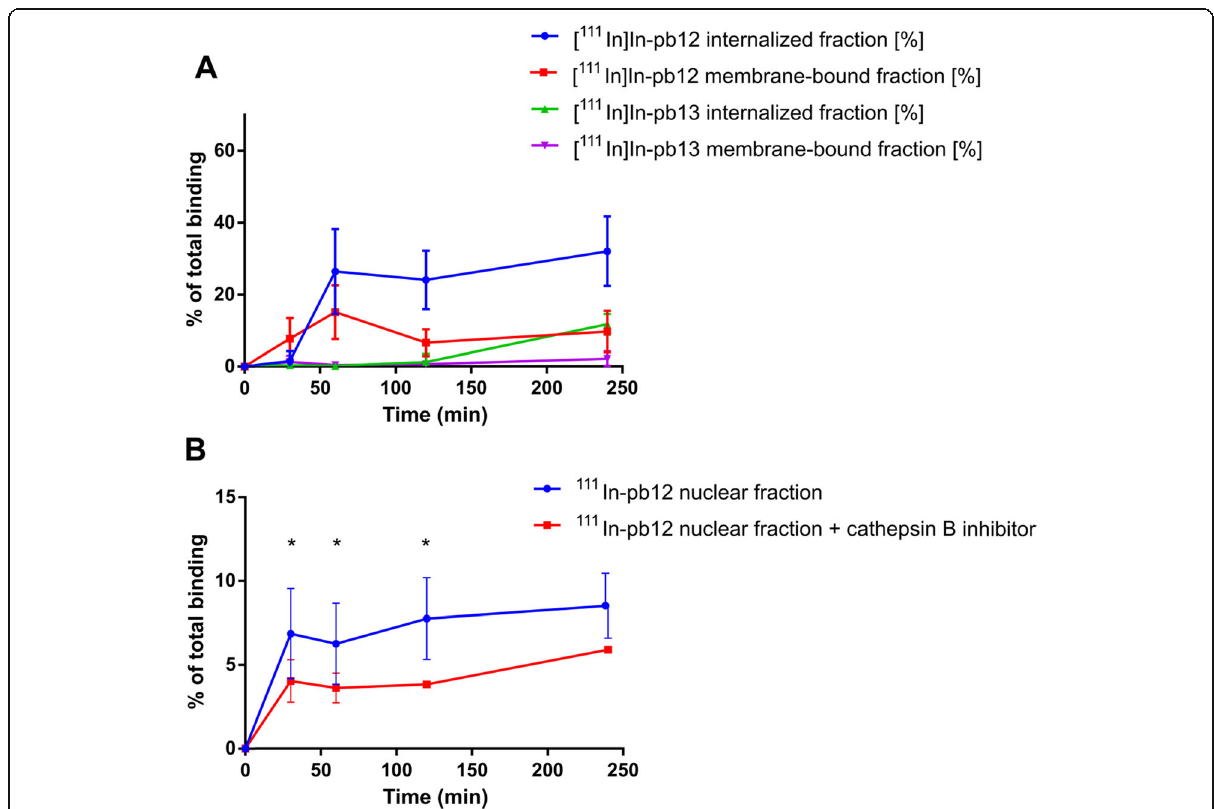
Fig. 5 Determination of the internalized fraction and membrane-bound fraction of [ 111 In]In-pb12 and control peptide [ 111 In]In-pb13 ( a ) and nuclear fractions of [ 111 In]In-pb12 with and without the cathepsin B inhibitor CA074Me ( b ) into endogenously hY 1 R-expressing MCF-7 cells. Data points represent the mean ± SD of at least two independent experiments